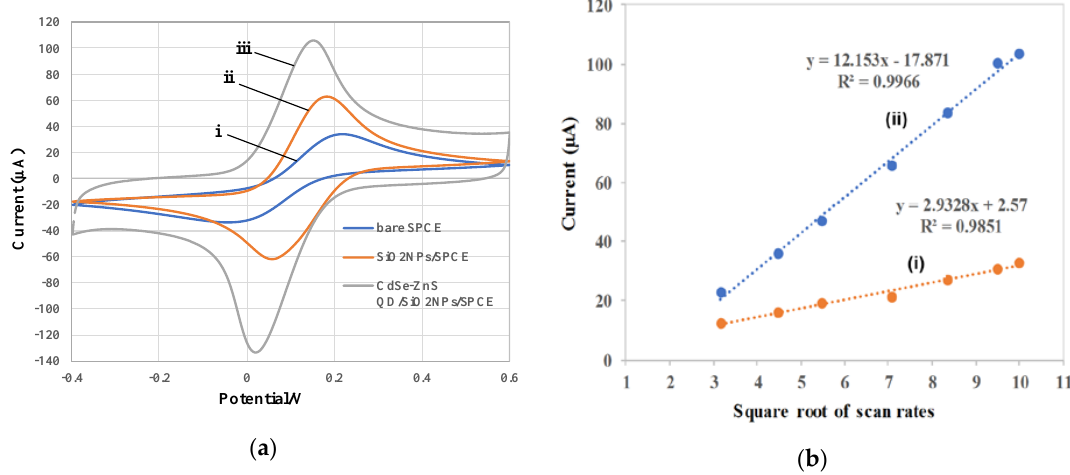
Figure 4. ( a ) Cyclic voltammetry (CV) responses for (i) bare SPCE, (ii) modified SiNPs/SPCE, and (iii) modified CdSe/ZnS QD/SiNPs/SPCE in 5.0 mM K 3 Fe(CN) 6 solution containing a supporting electrolyte, 0.1 M KCl, at 100 mV/s; ( b ) plot of the oxidation peak current of (i) bare SPCE and (ii) CdSe/ZnS QD/SiNPs/SPCE in 5.0 mM K 3 Fe(CN) 6 solution containing supporting electrolyte 0.1 M KCl at different scan rates (mV/s).